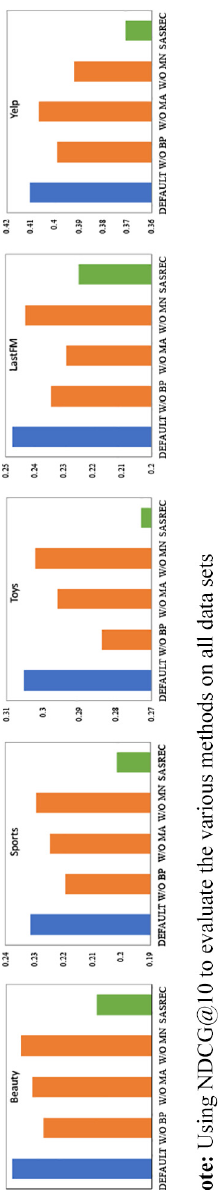
Figure 3. Ablation study of our